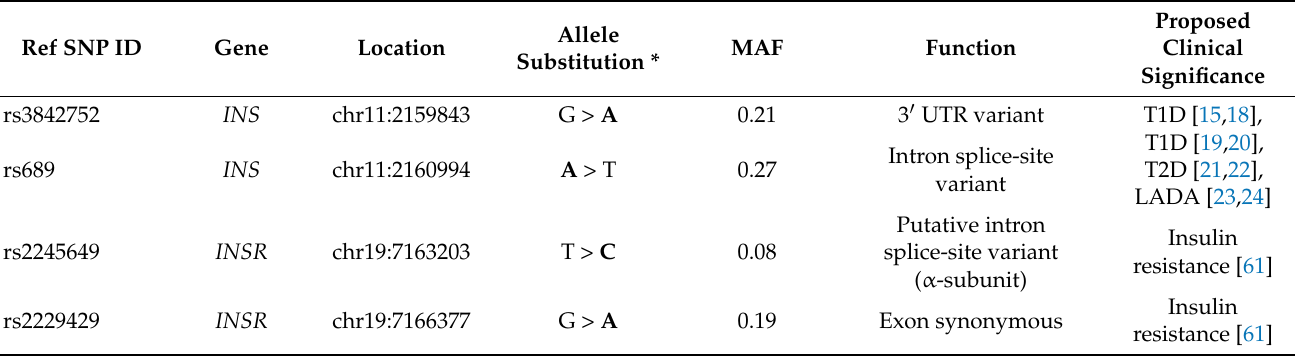
Table 5. Selected SNPs in INS and